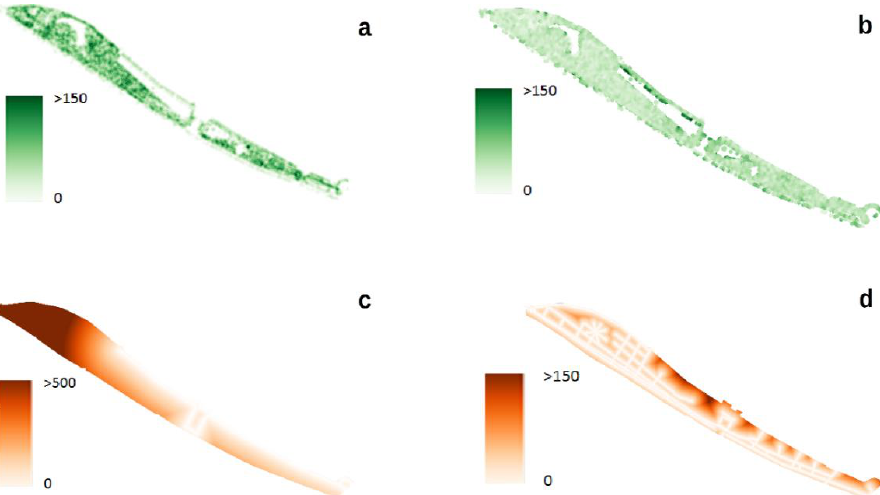
Figure 3. Density of trees (( a ); Unit of Measure - U.M.: tree/ha), average diameter (( b ); U.M.: cm), distance from roads with car access (( c ); U.M.: m), distance from footpaths (( d ); U.M.: m). Source: Own elaboration.